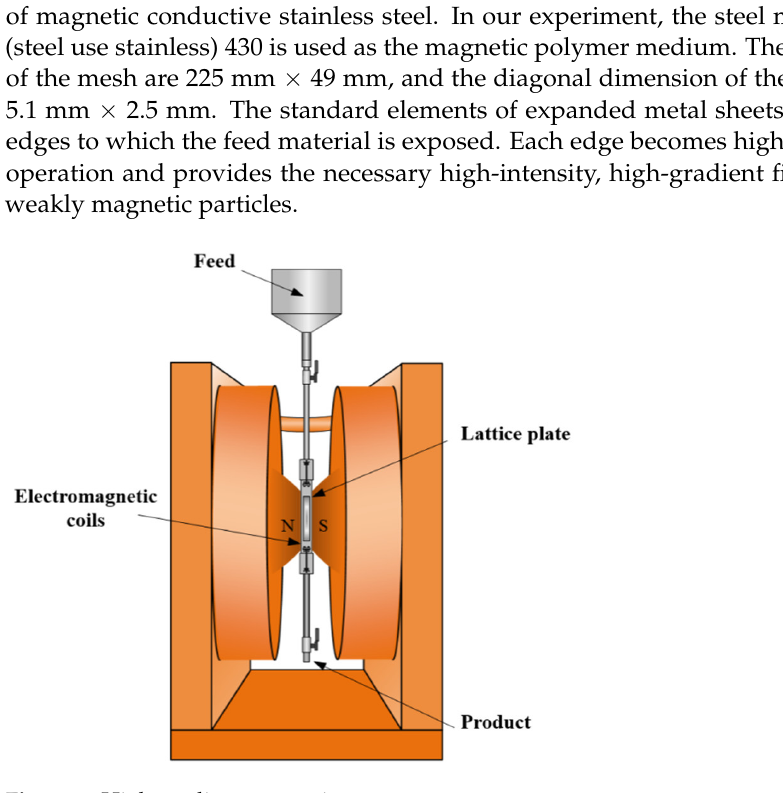
Figure 2. High gradient magnetic separator.